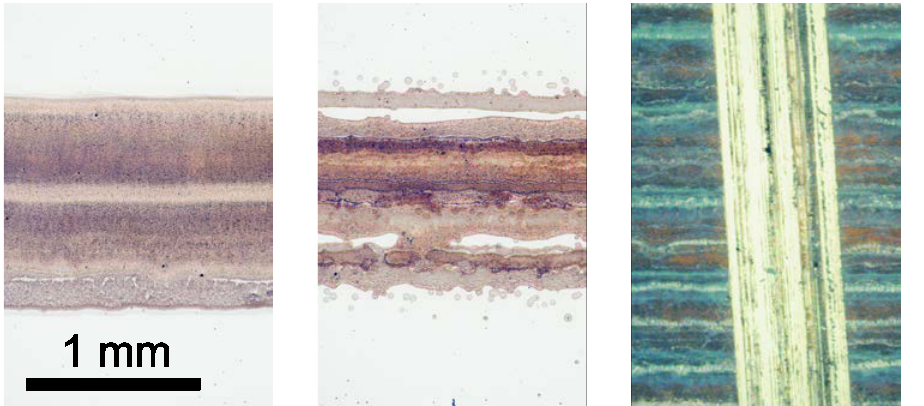
Figure 1. Optical micrographs of the printed layers showing the influence of ink composition on print quality. Formulation Ti_1 ( left ) featured good layer uniformity and excellent edge definition, but formulation Ti_5 ( middle ) suffered from occasional nozzle blockage and diverted droplets. The right image depicts a 3-layered patch of Ti_3 formulation featuring the banding artifacts and a scratch made with the pencil just harder than the layers